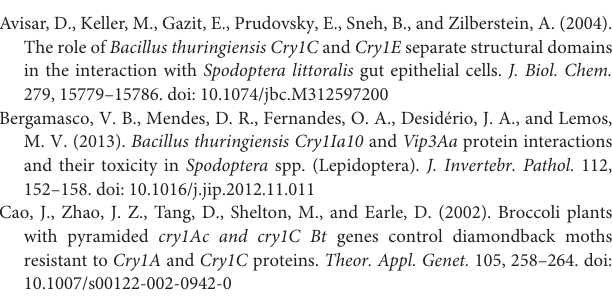
Figure S3 | (A) Interaction of Arg526 and Ser293 residues of fusion protein with Thr902 and Lys47 residues of Helicoverpa armigera APN receptor. (B) Interaction of Asn343 and Ile350 residues of fusion protein with Asp478 and Pro604 residues of Pectinophora gossypiella cadherin receptor. (C) Interaction of Asn484 and Ser293 residues of fusion protein with Ser515 and Thr582 residues of the Spodoptera exigua APN receptor. Figure S4 | (A) Interaction of fusion protein with Spodoptera exigua cadherin receptor. The Leu337 and Thr340 residues of fusion protein were interacting with Asp674 and Asp799 residues of the Spodoptera exigua cadherin receptor. (B) Interaction of Ser290 and Ser293 residues of fusion protein with Phe877 and Thr885 residues of Spodoptera litura APN receptor. (C) Interaction of fusion protein with Spodoptera litura cadherin receptor. The Tyr313 and Tyr306 residues of fusion protein were interacting with Tyr490 and Gln626 residues of Spodoptera litura cadherin receptor. Table S1 | Interaction of fusion protein with Helicoverpa armigera aminopeptidase-N (APN) receptor. Out of 24 hydrogen bonds present in the docked complex two were less than 2.5 Å in the distance (highlighted). Table S2 | Interaction of fusion protein with Pectinophora gossypiella cadherin receptor. Out of 23 hydrogen bonds present in the docked complex two were less than 2.5 Armstrong in distance (highlighted). Table S3 | Interaction of fusion protein with Spodoptera exigua APN receptor. Out of 8 hydrogen bonds present in the docked complex two were less than 2.5 Armstrong in the distance (highlighted). Table S4 | Interaction of fusion protein with Spodoptera exigua cadherin receptor. Out of 8 hydrogen bonds present in the docked complex two were less than 3.5 Armstrong in distance (highlighted). Table S5 | Interaction of fusion protein with Spodoptera litura APN receptor. Out of 19 hydrogen bonds present in the docked complex two were less than 2.5 Armstrong in the distance (highlighted). Table S6 | Interaction of fusion protein with Spodoptera litura cadherin receptor. Out of 10 hydrogen bonds present in the docked complex two were less than 3 Armstrong in the distance